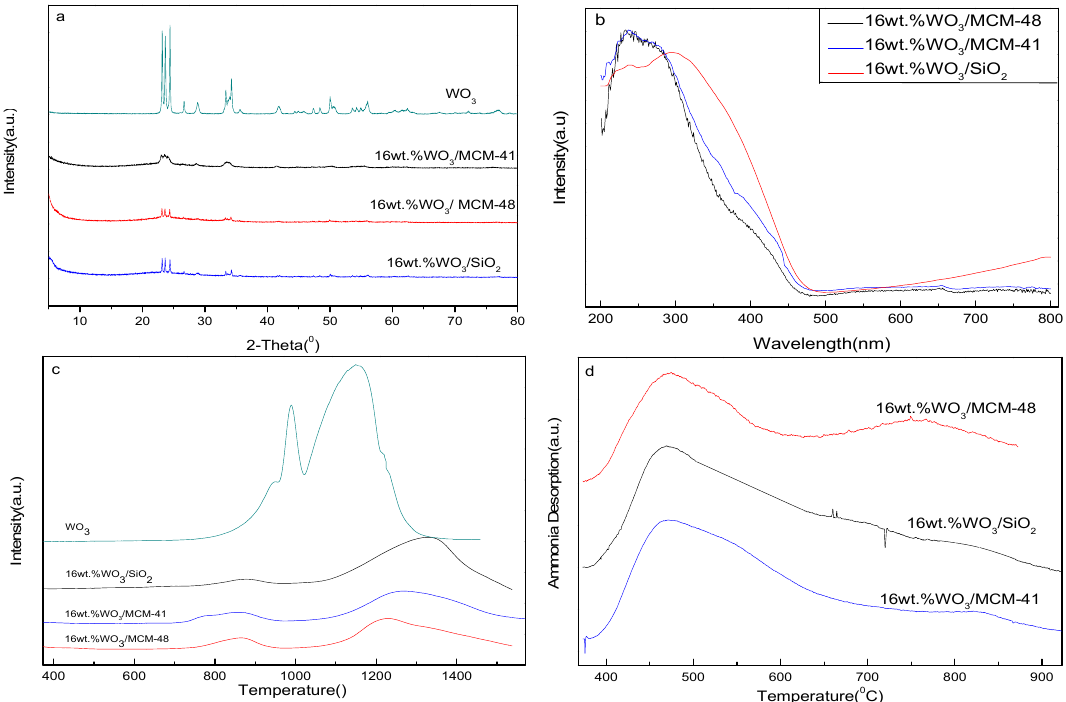
Figure 2. Effect of supports on structural characteristics of catalysts. ( a ) XRD patterns of catalysts, ( b ) UV-vis DRS of catalysts, ( c ) TPR of catalysts, ( d ) NH 3 -TPD of catalysts.